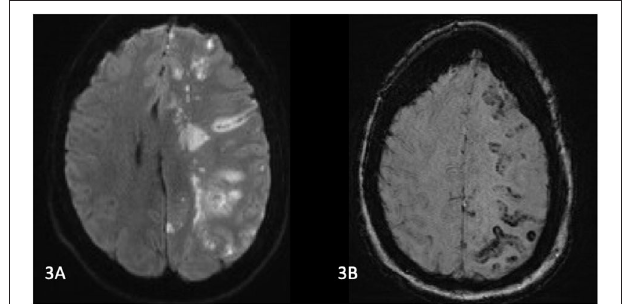
FIGURE 3 | (A) MRI Brain on day 1 post operatively. Diffusion weighted images show left MCA territory infarction with a similar distribution of abnormalities on suspectibility weighted imaging) (B) . MCA, middle cerebral artery; DWI, diffusion weight imaging; ECR, endovascular clot